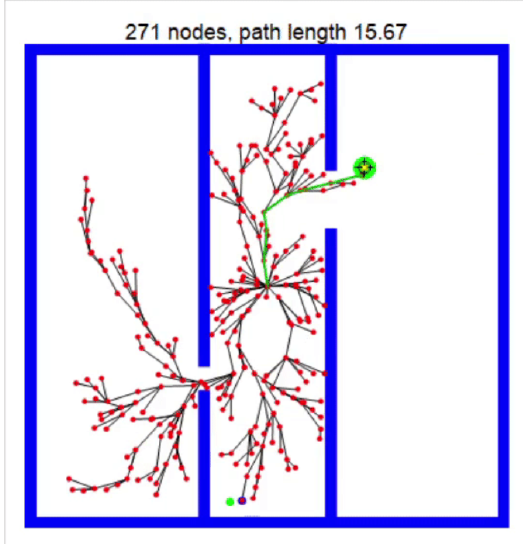
Figure 4. Exploration of RRT*, which improves on the existing tree by rewiring the tree to form the shortest paths